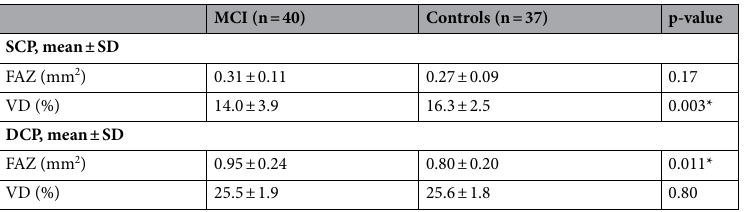
Table 2. Comparison of optical coherence tomography angiography parameters between patients with mild cognitive impairment and controls. MCI = mild cognitive impairment, SCP = superficial capillary plexus, FAZ = foveal avascular zone, VD = vessel density, DCP = deep capillary plexus, SD = standard deviation. *p < 0.05.